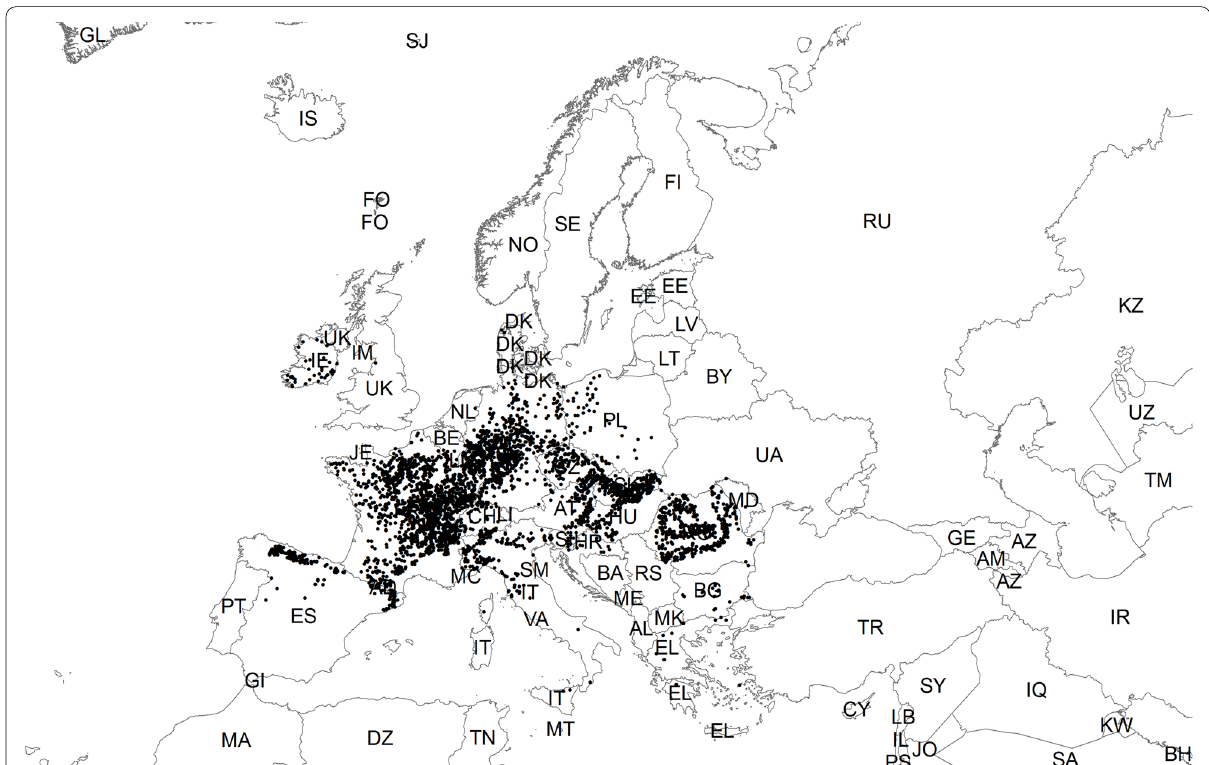
Fig. 7 Map of training segments assigned to